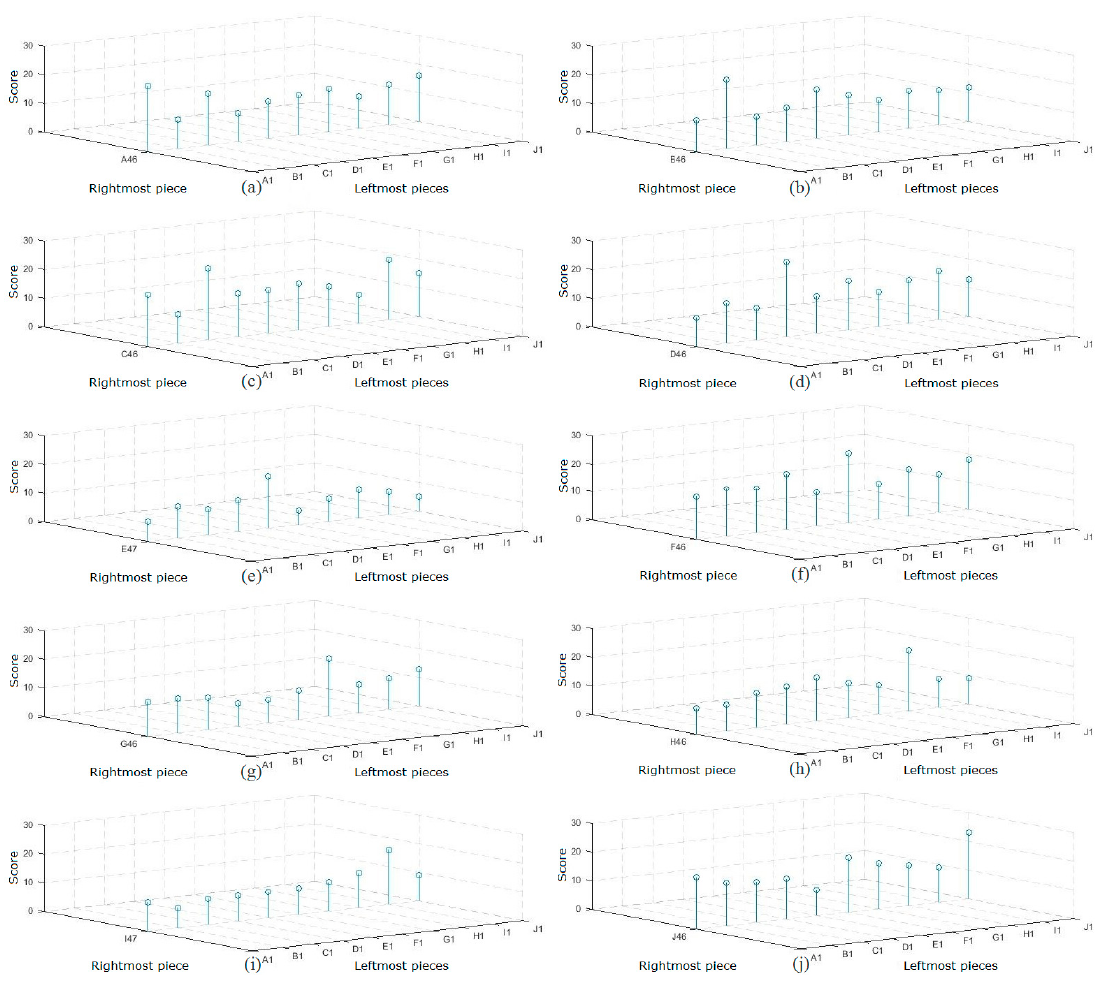
Figure 19. Matching results between each rightmost piece and all leftmost pieces: ( a ) the rightmost piece in document A and all leftmost pieces; ( b ) the rightmost piece in document B and all leftmost pieces; ( c ) the rightmost piece in document C and all leftmost pieces; ( d ) the rightmost piece in document D and all leftmost pieces; ( e ) the rightmost piece in document E and all leftmost pieces; ( f ) the rightmost piece in document F and all leftmost pieces; ( g ) the rightmost piece in document G and all leftmost pieces; ( h ) the rightmost piece in document H and all leftmost pieces; ( i ) the rightmost piece in document I and all leftmost pieces; ( j ) the rightmost piece in document J and all leftmost pieces.